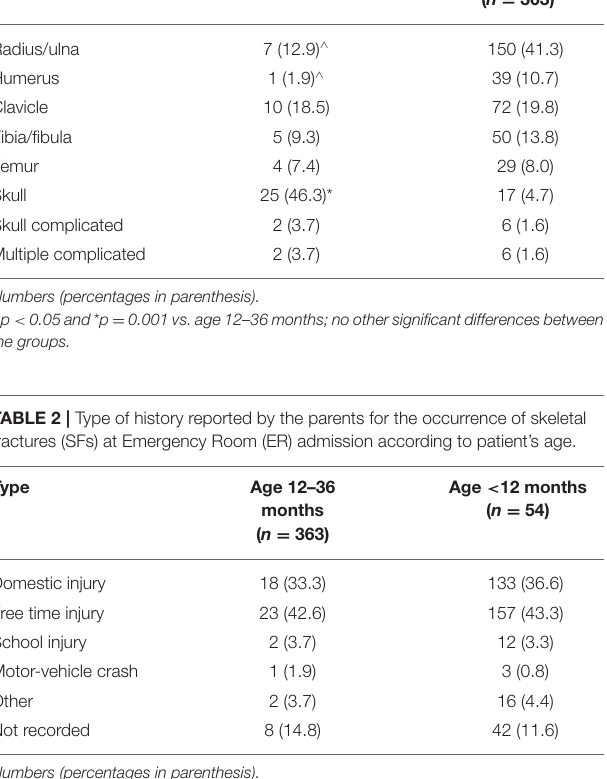
TABLE 3 | Number of indicators of child abuse registered at ER admission according to patient’s age. Risk indicators for abuse ( n